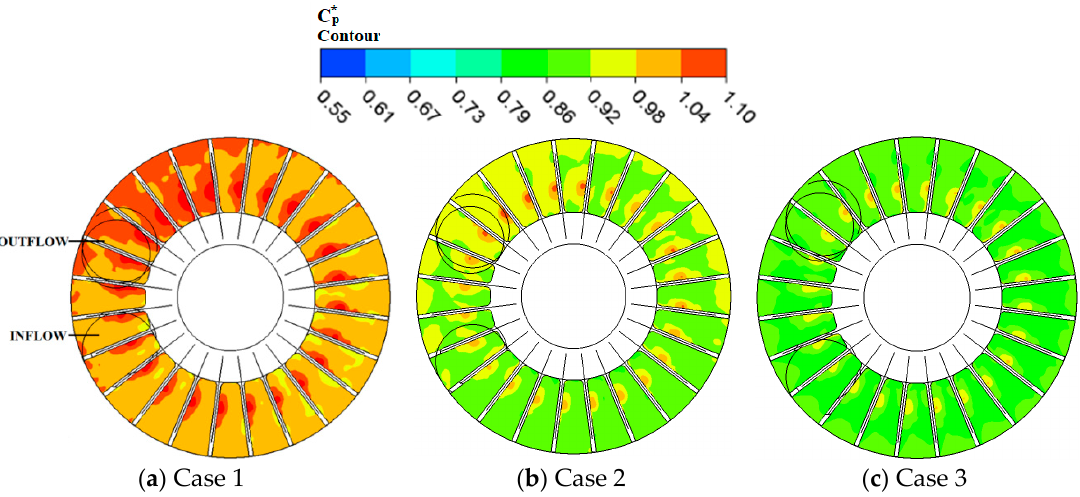
Figure 8. Pressure fluctuation intensity of impeller passage for three pump cases on plane 1.